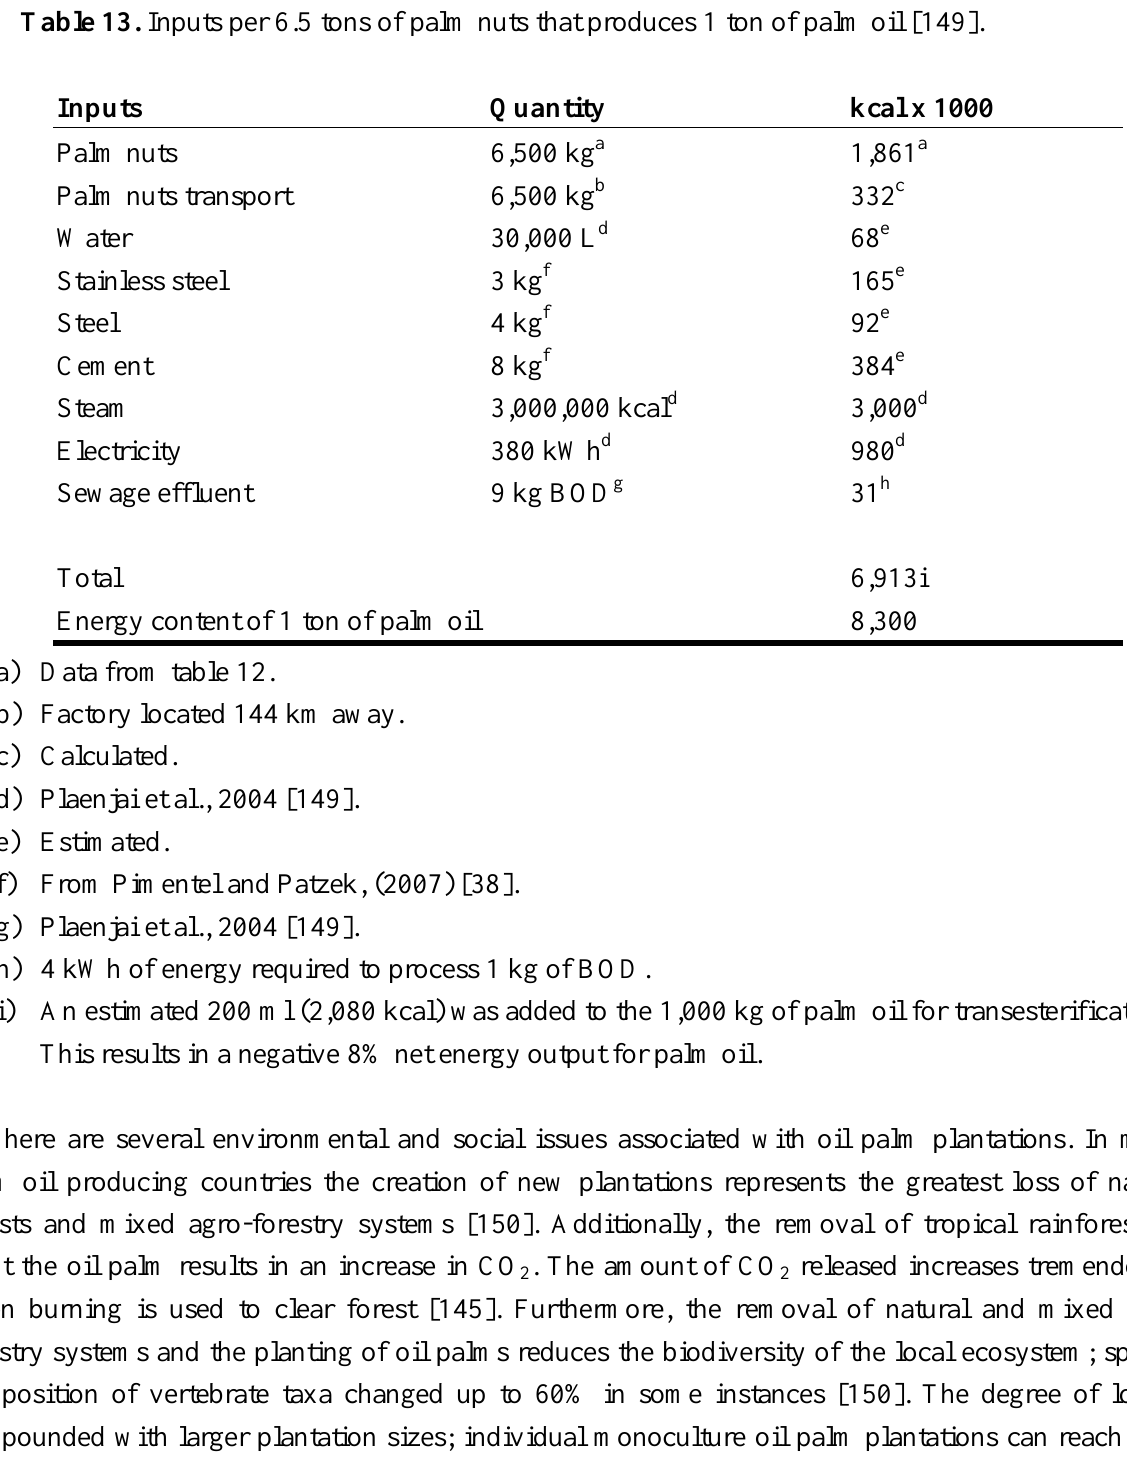
Table 13. Inputs per 6.5 tons of palm nuts that produces 1 ton of palm oil